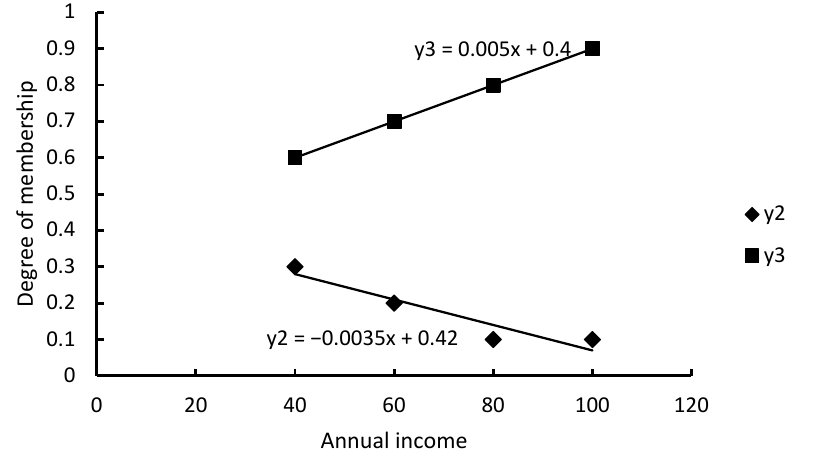
Figure A12. Single factor evaluation for the index of annual income (more than 40 ten thousand yuan).